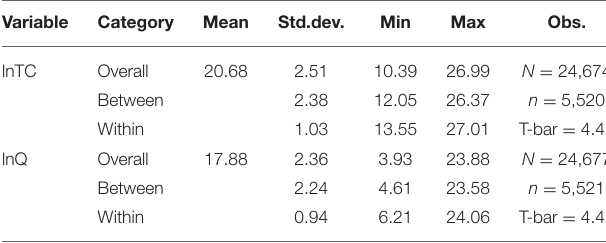
TABLE 3 | Descriptive statistics.